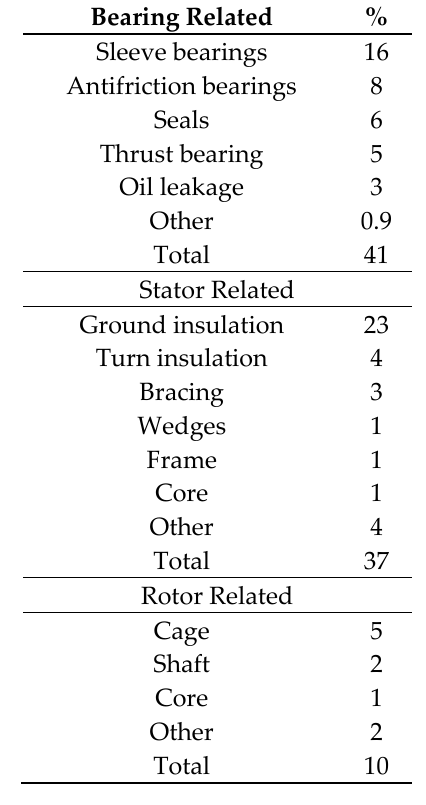
Table 6. Failures according to the electric motor